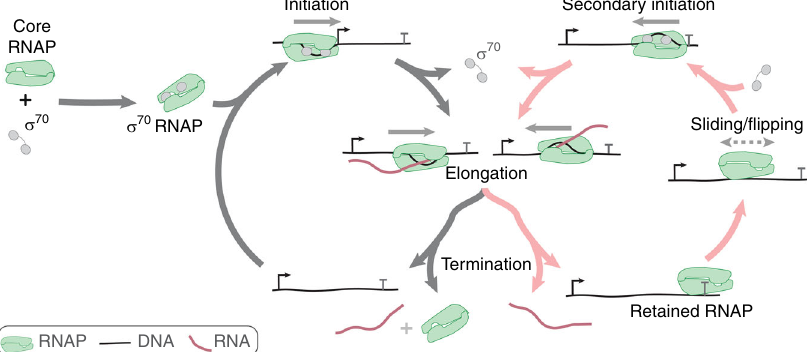
Fig. 6 Proposed expanded bacterial transcription mechanism. RNAP retention after termination leads to an expanded pathway for transcript production, consisting of linked canonical (gray) and alternative (red) cycles. See text. Antisense promoter-like and terminator sequences are not